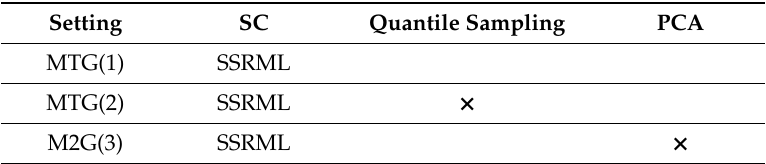
Table 3. Settings of the MTG